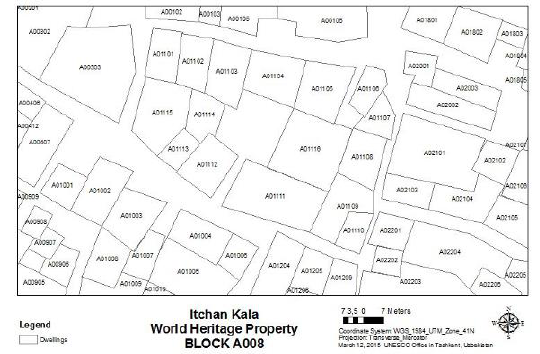
Figure 10. Example of key map provided for Itchan Kala, with the distribution of the dwellings, ID blocks and ID number.